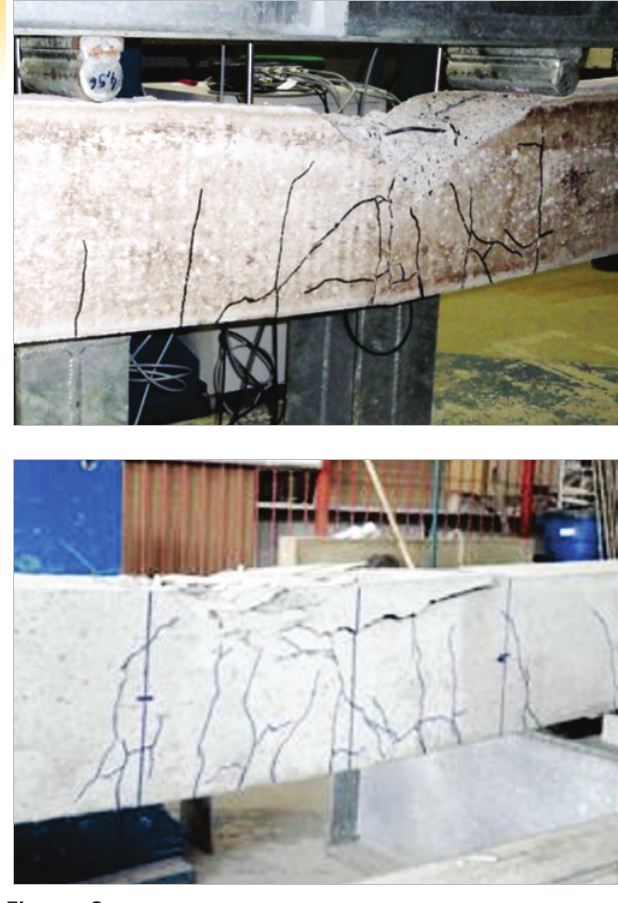
Figure 8 State of the beams after the